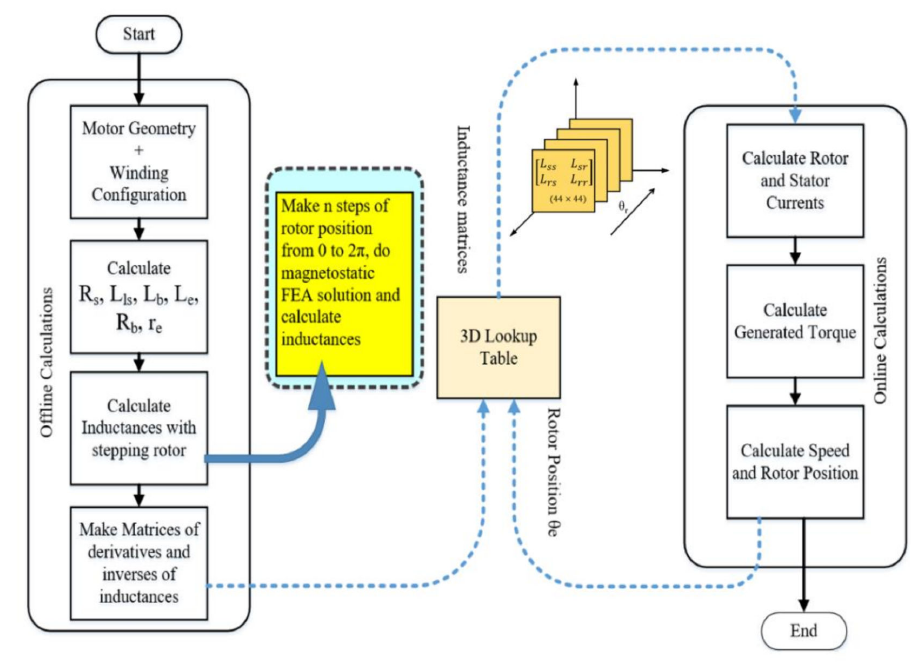
Figure 1. The schematic diagram of inductances calculations and their implementations for dynamic simulation.